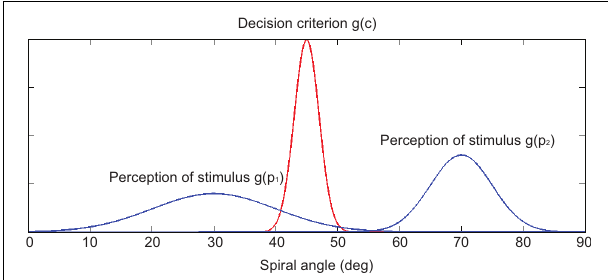
FIGURE 2 | Schematic illustration of the computational model. An example of the Double Model is shown here. The decision process can be considered as comparing the perceived spiral angle of a stimulus ( p i ) with the implicit decision criterion ( c i ). If p i > c i , the stimulus was categorized as a concentric pattern. Otherwise, if p i < c i , the stimulus was categorized as a radial pattern. The red curve represents the decision criterion. The two blue curves represent the perceived spiral angle of two stimuli with different signal strengths: the left blue curve represents the perception of a low-signal-strength Glass Pattern whose spiral angle was 30 ◦ ,and the right blue curve represents the perception of a high-signal-strength Glass Pattern whose spiral angle was 70 ◦